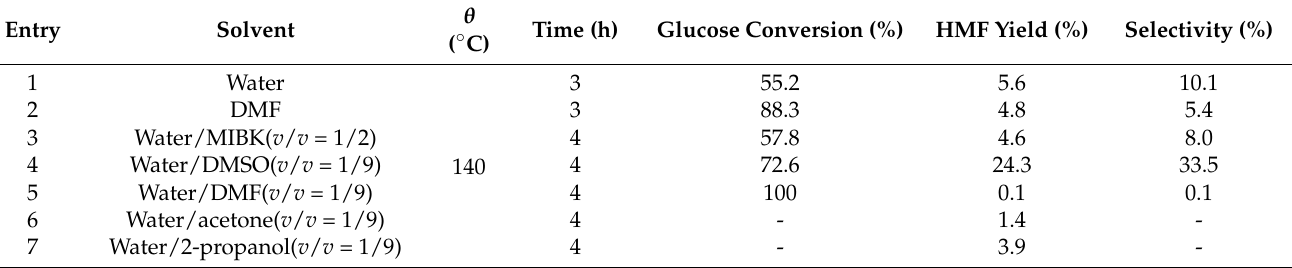
Table 4. Solvent effect on glucose conversion.